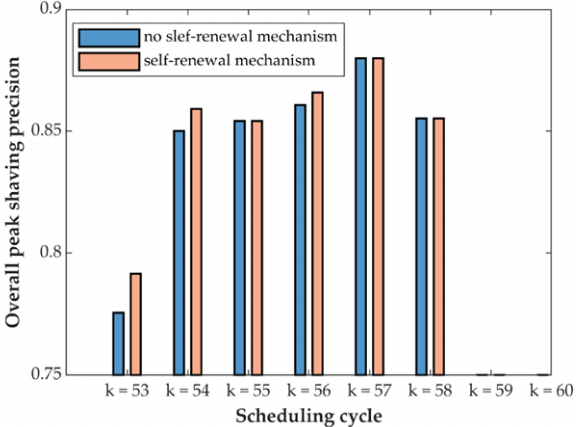
Figure 11. Overall precision based on the self-renewal mechanism.